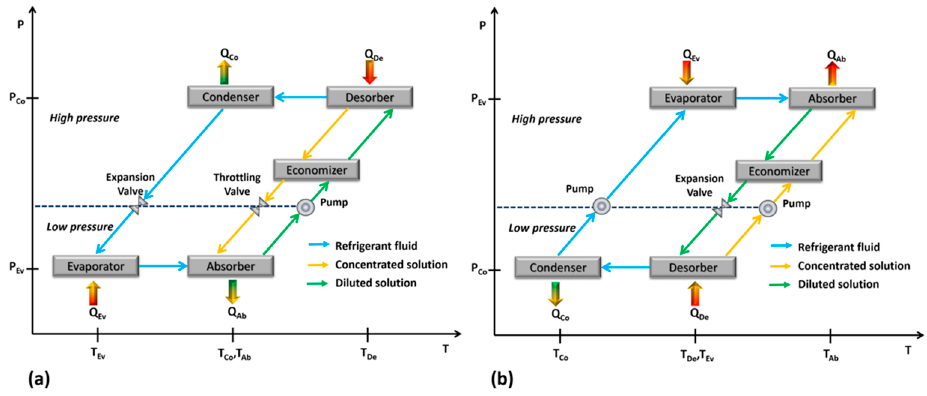
Figure 1. An absorption chiller diagram ( a ), and an absorption heat transformer diagram ( b ).